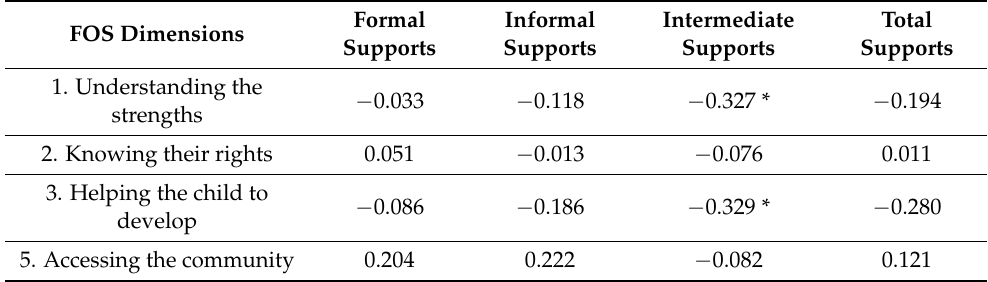
Table 6. Relationships between empowerment and the support network. FOS Dimensions